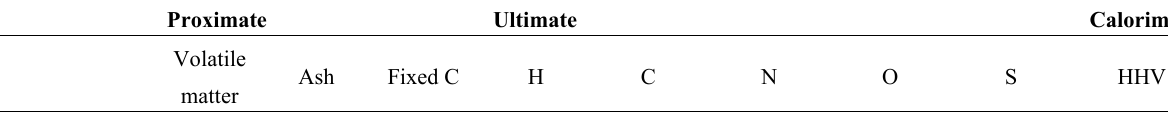
Table 2. Descriptive statistics (mean and standard error) based on proximate, ultimate, and calorimeter analysis of a small subset of individual incremental stover samples, for above ear n = 22, below n = 76 average among locations described in Table 1. Proximate Ultimate